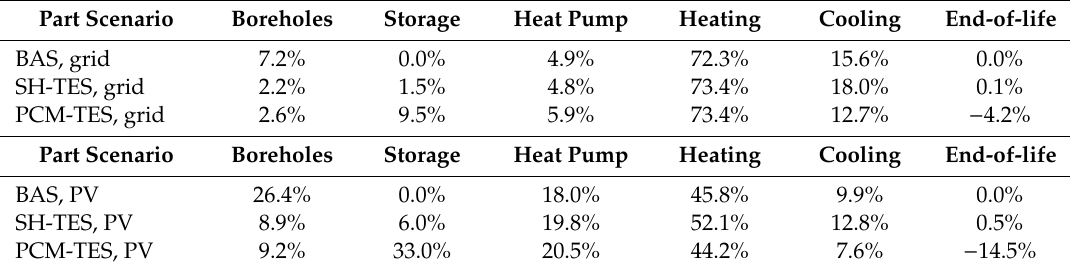
Table 8. Incidence of di ff erent life-cycle assessment (LCA) parts on global warming.